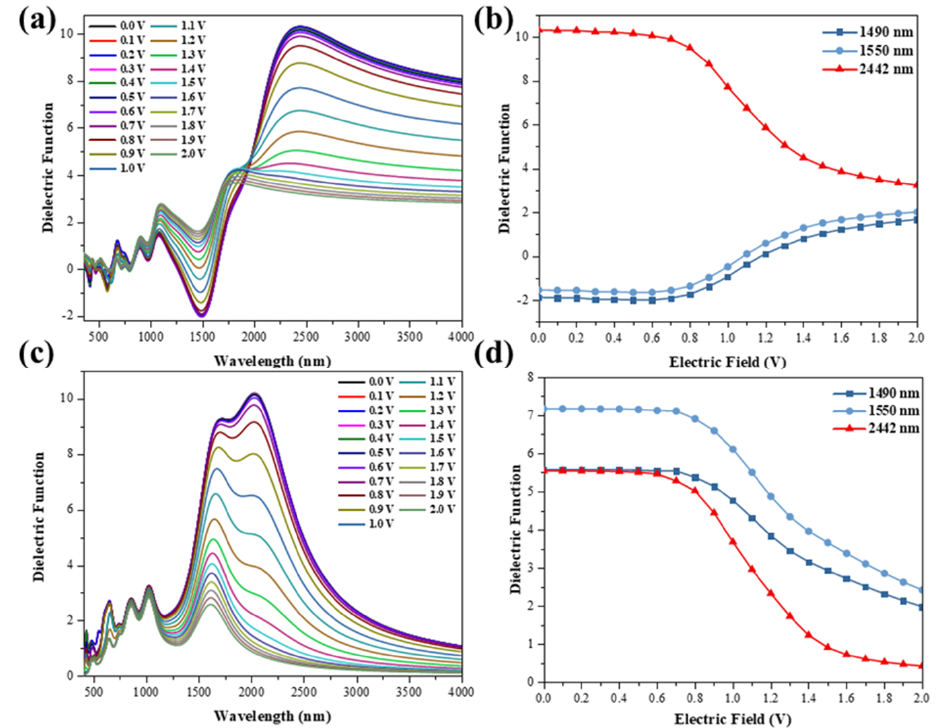
Figure 3. The real ( a ) and imaginary ( c ) parts of the dielectric function of the external electric field induced TBG in the x direction. The variation of the real ( b ) and imaginary ( d ) parts of the dielectric function with the tunable external electric field is analyzed. Field intensity is defined as v/nm.